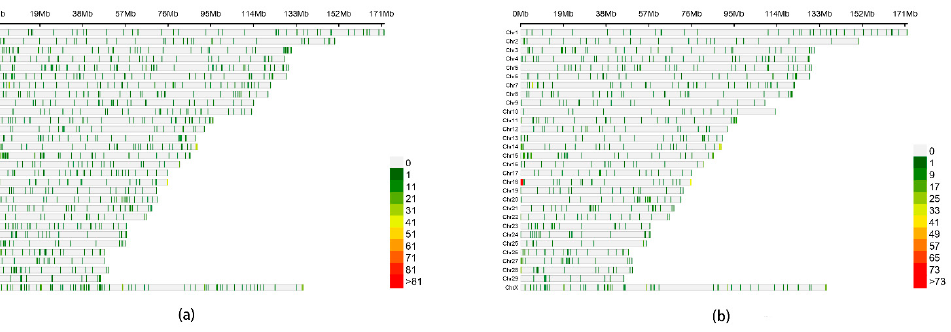
Table 2. Summary of CNV testing.